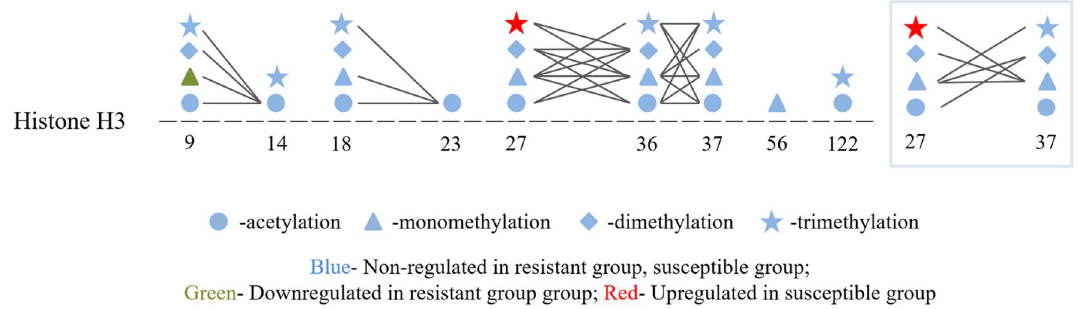
Figure 6. Crosstalks of posttranslational modifications (PTMs) on histone H3 PTMs. Distinctive types of crosstalks are indicated by connecting